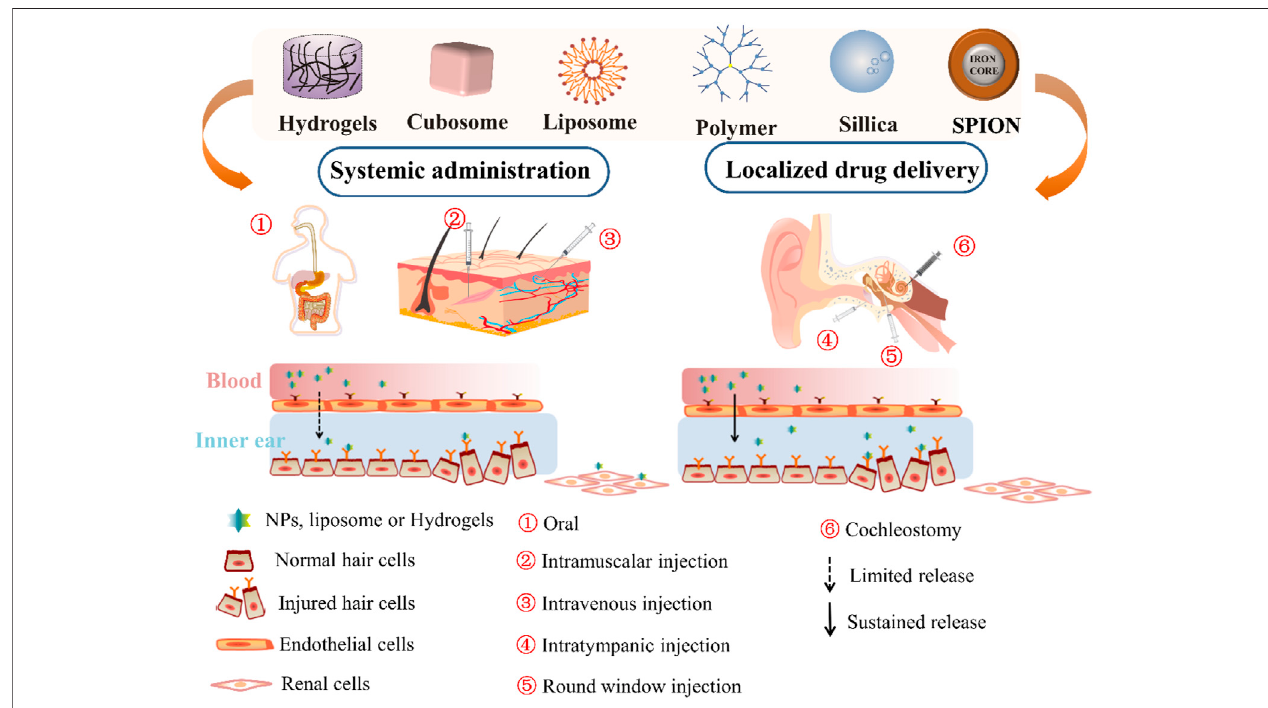
FIGURE 1 | Scheme of the general administration route of nanomaterials, including hydrogels, cubosome nanoparticles (NP), liposomes, polymer NP, silica NP, and SPION for inner ear therapy. SPION, supermagnetic iron oxide nanoparticle.